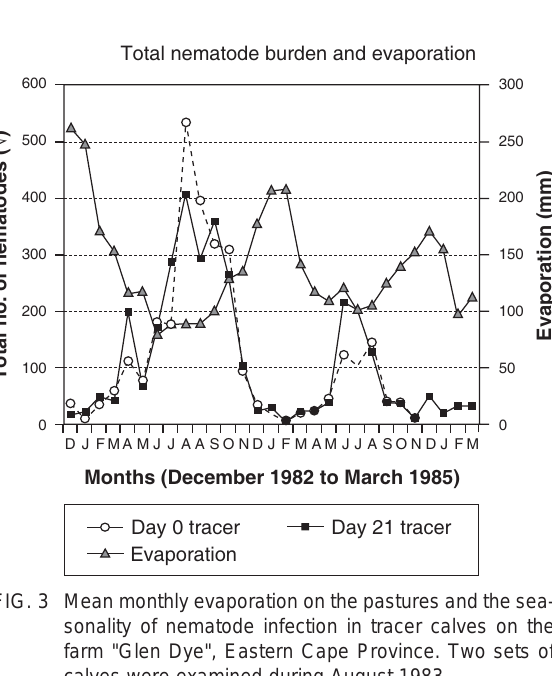
FIG. 3 Mean monthly evaporation on the pastures and the sea- sonality of nematode infection in tracer calves on the farm "Glen Dye", Eastern Cape Province. Two sets of calves were examined during August